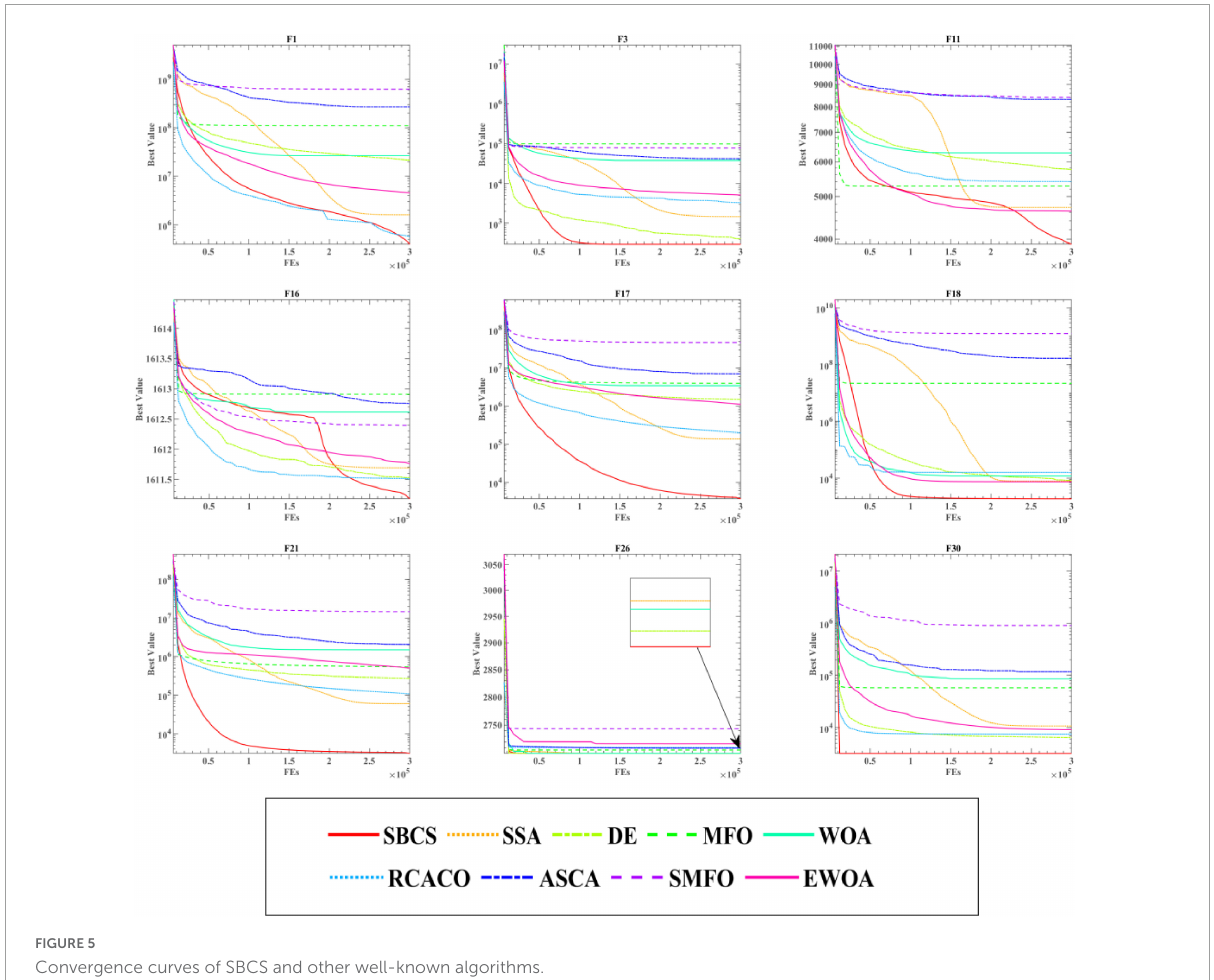
FIGURE5 Convergence curves of SBCS and other well-known algorithms.